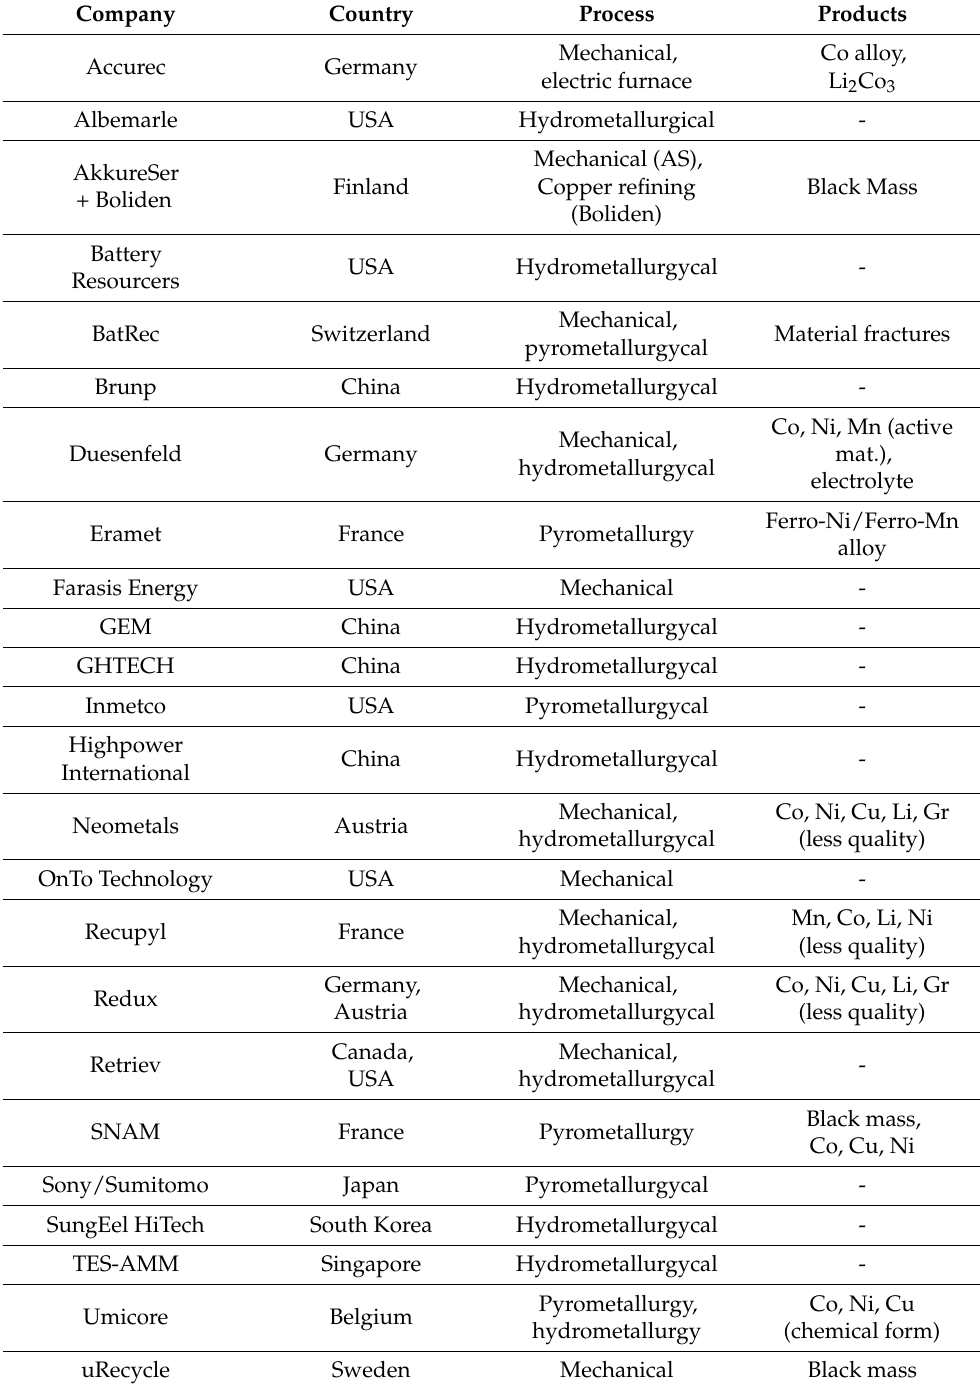
Table 4. Major LIBs recycling facilities worldwide according to